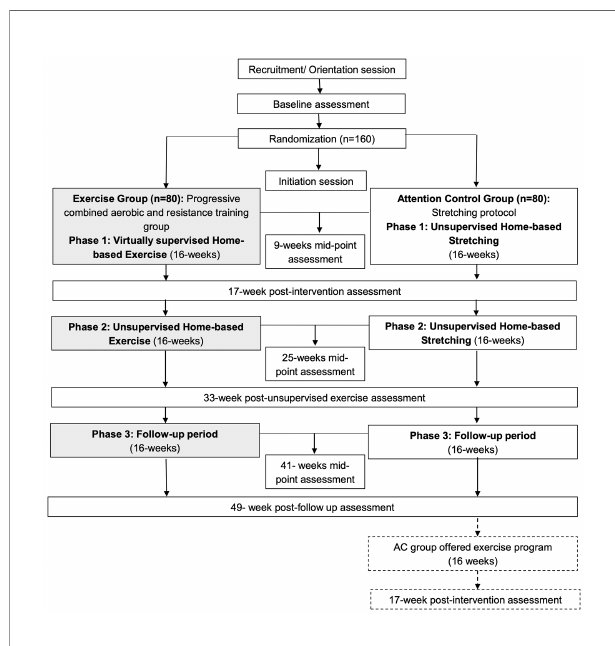
FIGURE 2 | Study schema of the ROSA Trial.